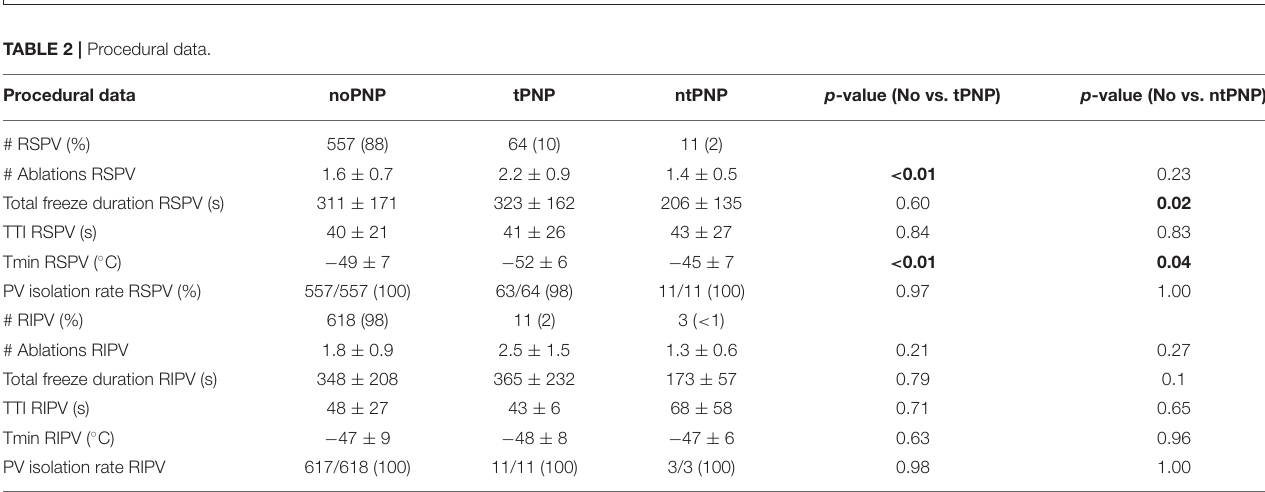
FIGURE 1 | Distribution of tPNP and ntPNP at the right-sided pulmonary veins. Most of the PNP occur during cryoenergy ablation of the RSPV, whereas PNP during ablation of the RIPV is a rare event.